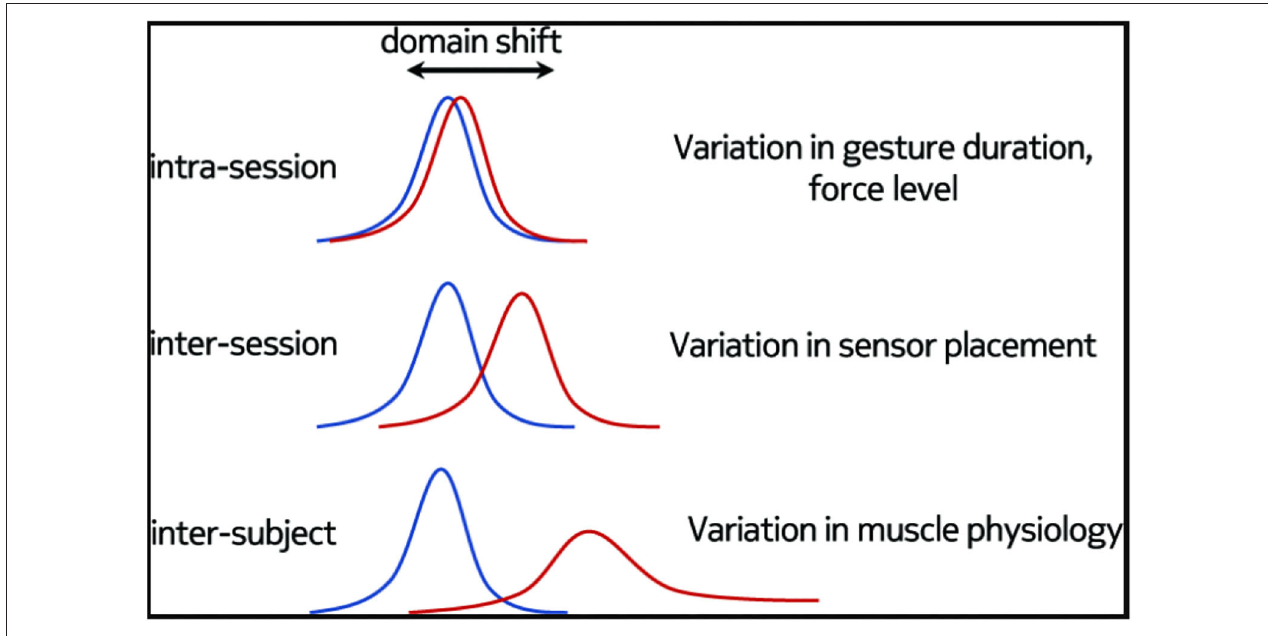
FIGURE 5 | Causes of variability of data distribution (Ketyko et al.,